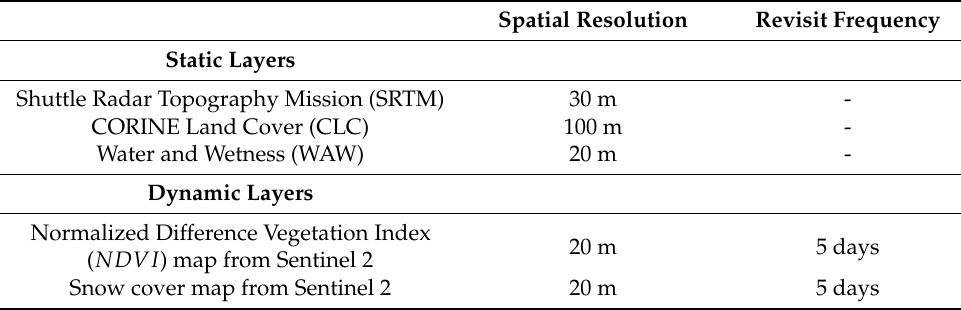
Figure 2. NDVI map updated on 12 January 2021. Gaps correspond to pixels where no cloud-free S2 data were available in the last 30 days (i.e., since 12 December 2020), or to pixels covered by snow, or water bodies. Table 1. Spatial resolution and revisit frequency of the ancillary